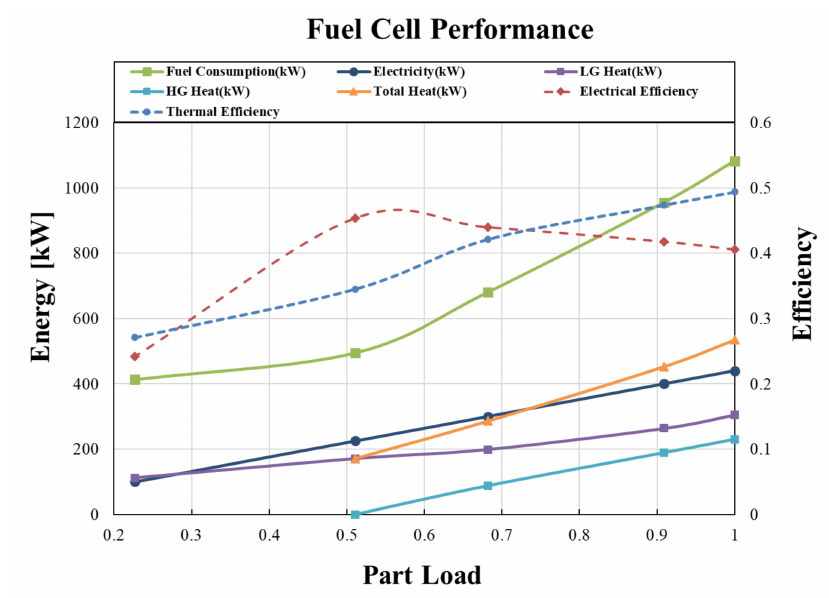
Figure 4. Correlation performance data for a 440 kW